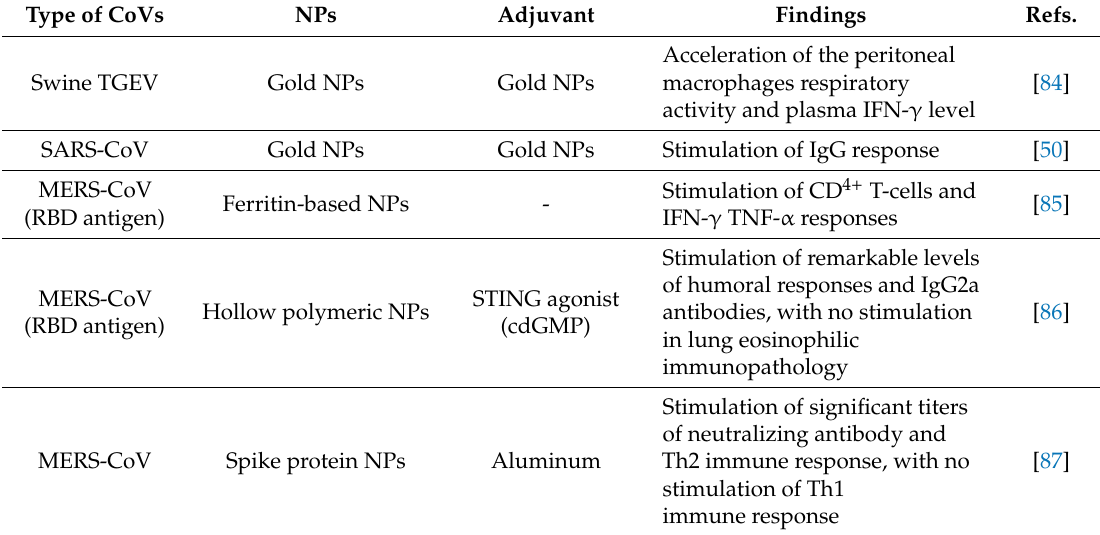
Table 4. Some important examples of NP-based vaccine candidates against